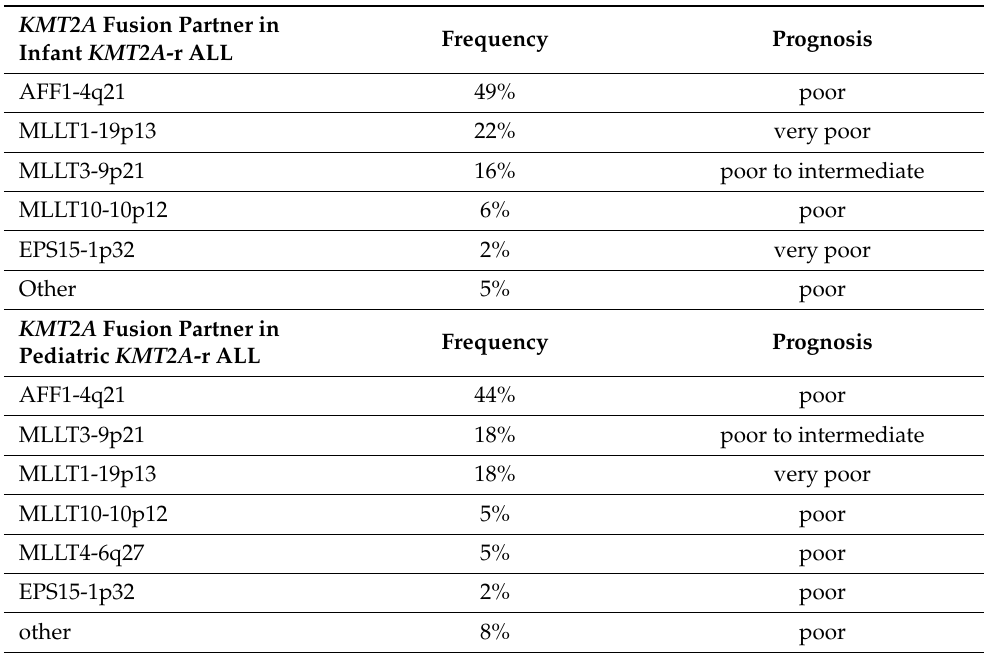
Table 1. Examples of common KMT2A fusion partners in KMT2A -r ALL, with their frequency and prognosis. The frequency rate is based on the study group of 1005 KMT2A -r ALL infant and pediatric patients (out of 2345 study groups)